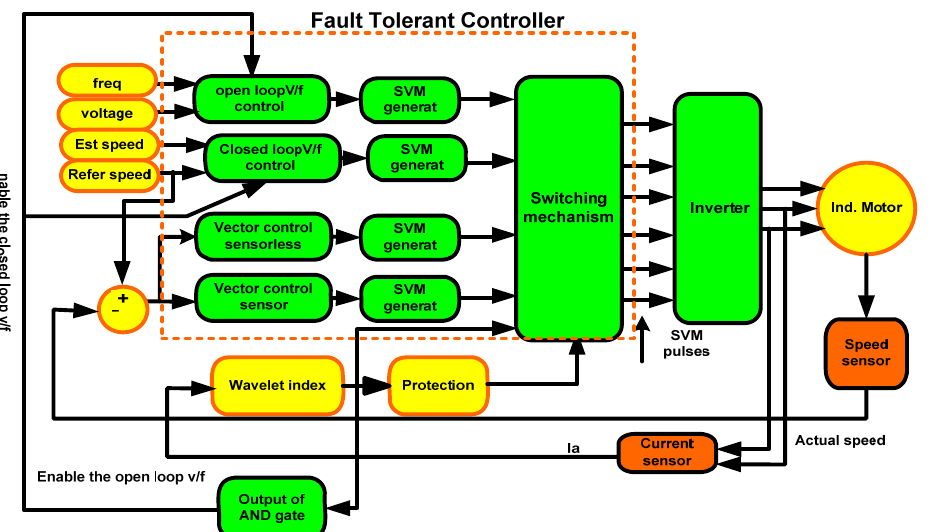
Figure 10. Fault tolerant control algorithm.